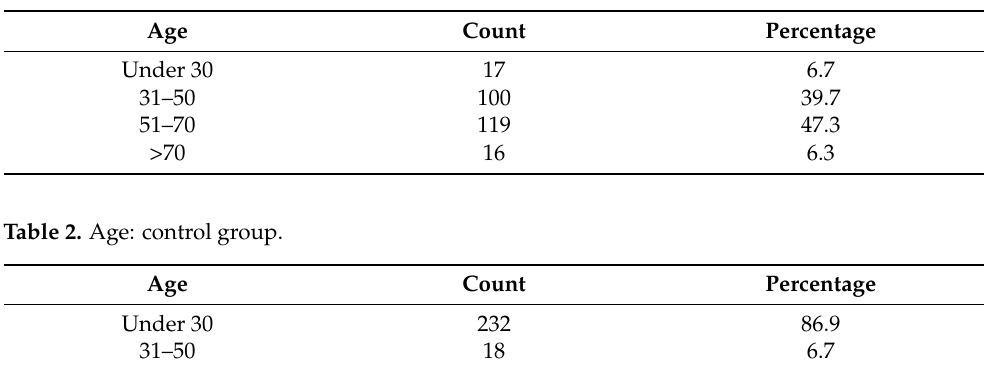
Table 1. Age: experimental group.